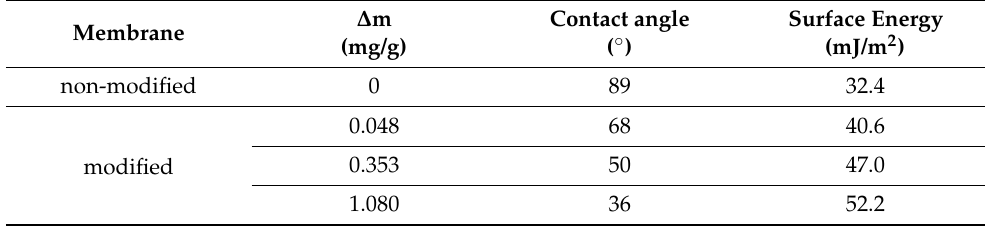
Table 9. The dynamic contact angle and surface energy of the G-series membrane (grafting yield (GY) 1.82 mg/cm 2